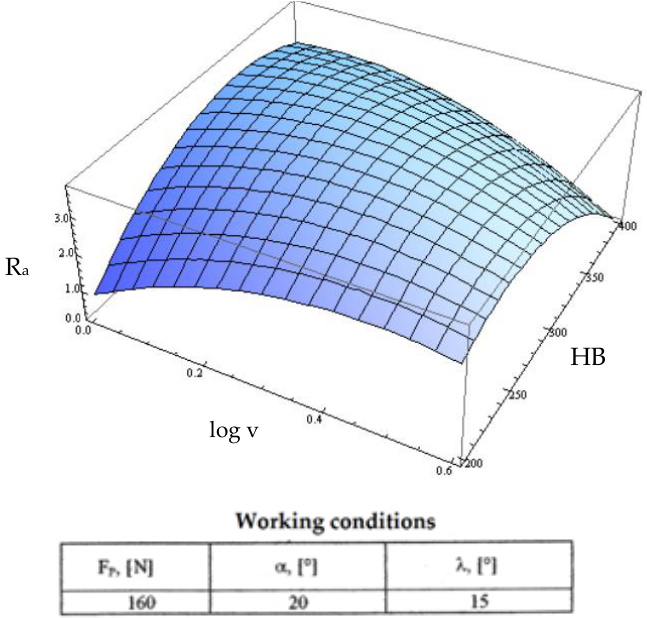
Figure 17. Influence of the inclination angle and cutting speed v on roughness R a.